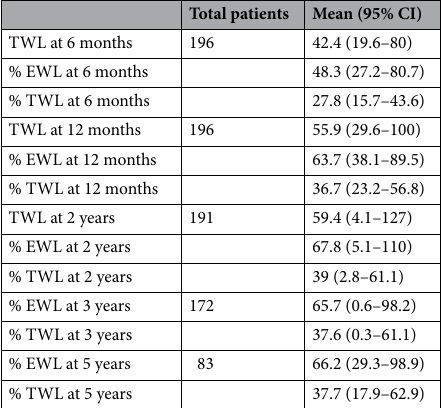
Table 2. Weight loss outcomes in patients undergoing one anastomosis gastric